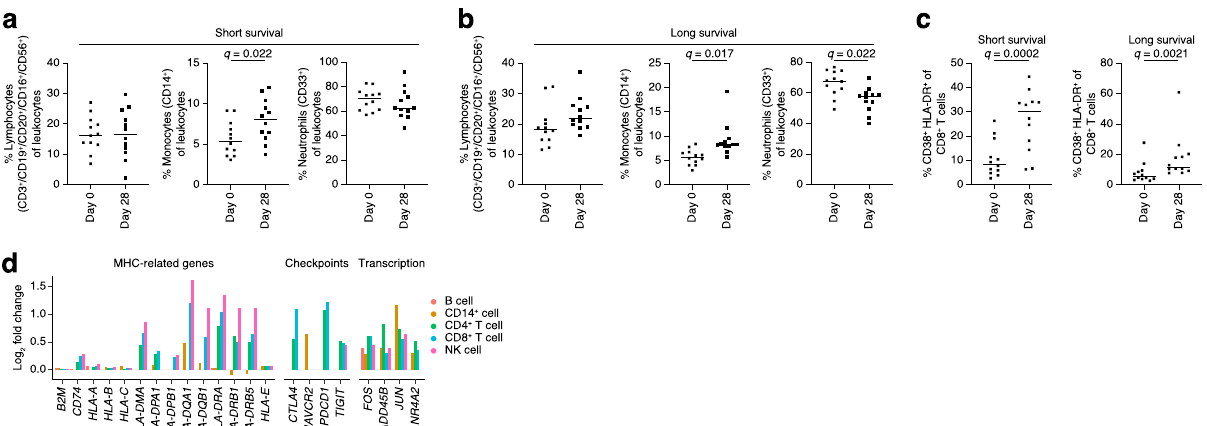
Fig. 3 Immune pro fi les of pre- and post-treatment (one cycle) blood samples. a – c Flow cytometry analyses of changes in circulating cell populations in shorter and longer survivors following treatment with entinostat and pembrolizumab. Gating strategies can be found in Supplementary Fig. 5. ( a ) Graphs showing the frequency of CD3 + lymphocytes (left), CD14 + monocytes (middle), and CD33 + neutrophils (right) among patients with shorter ( n = 12) and ( b ) longer ( n = 12) survival prior to (circles) or after (squares) one cycle of treatment. ( c ) Analysis of CD8 + cytotoxic T cells in patients with shorter and longer survival. Statistical analysis was performed using multiple paired t-tests correct for multiple comparisons using a two-stage step-up (Benjamini, Krieger, and Yekutieli) with test between all groups in ( a – b ), where * indicates adjusted p -values < 0.05. d White blood cells from three patients were analyzed by 10x Genomics TCR and gene expression analysis. Statistically altered genes in different cell types after treatment in the categories antigen presentation, immune-checkpoint receptors, and transcriptional regulation. n = 3 patient samples were compared pre- and post treatment. Genes shown were signi fi cant at q < 0.05. p -values were calculated with Wilcoxon rank-sum tests and adjusted for multiple comparisons with the Benjamini – Hochberg method. All statistical tests were two-sided. Source data are provided as a Source Data fi